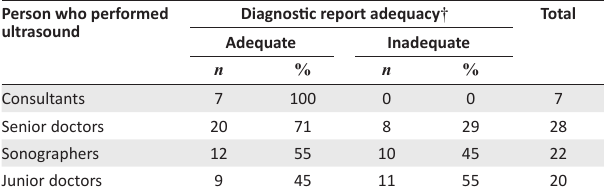
TABLE 3: Adequacy of diagnostic reports by different